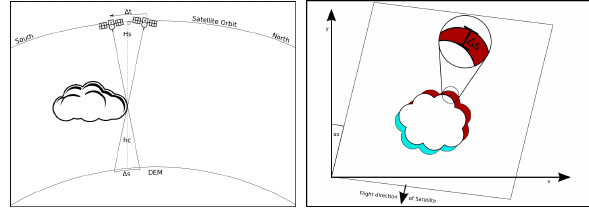
Figure 7: Acquisition geometry of clouds in RapidEye imagery, left: side view, right: top view